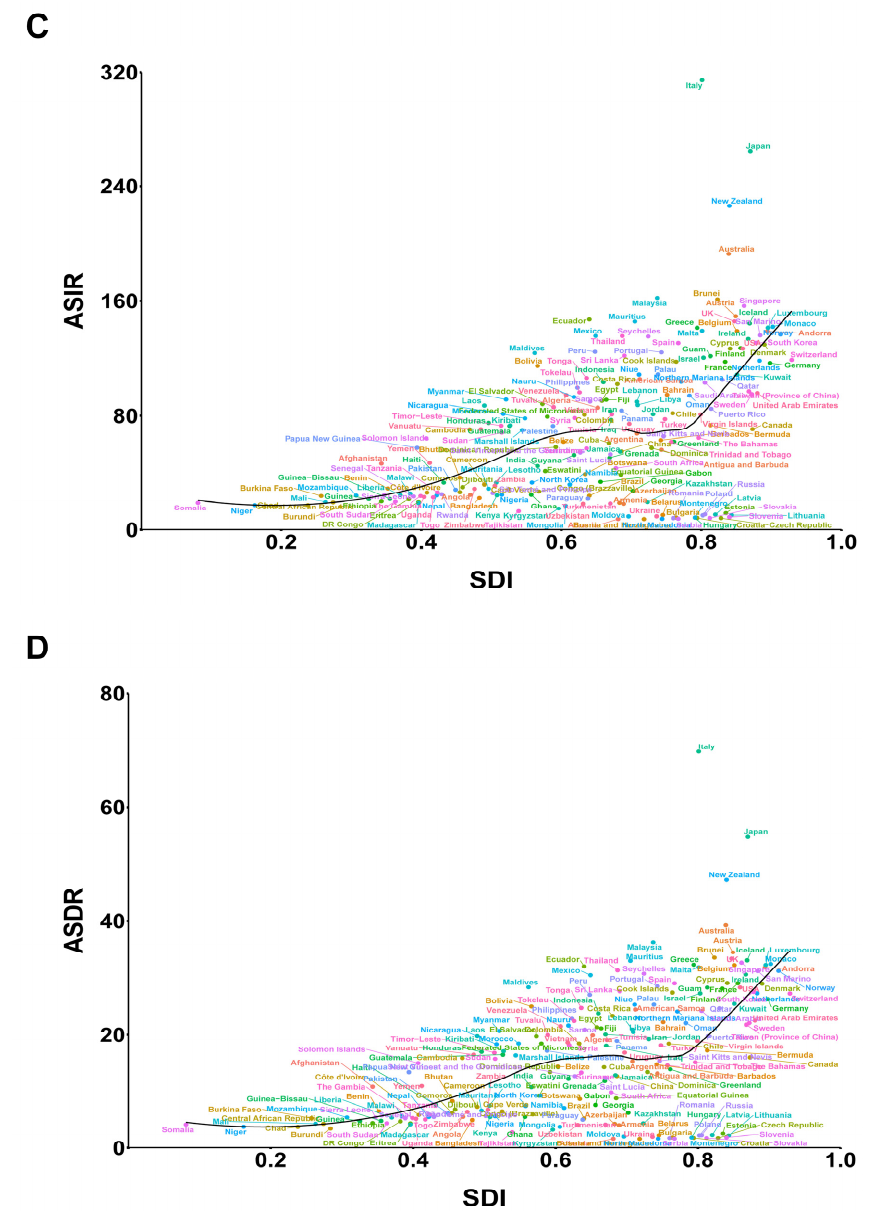
Figure 4. Correlation between SDI and ASR of PCOS at regional and national levels. ( A ) Correlation between SDI and ASIR (per 100,000) at the regional level from 1990 to 2019. ( B ) Correlation between SDI and ASDR (per 100,000) at the regional level from 1990 to 2019. ( C ) Correlation between SDI and ASIR at the national level in 2019. ( D ) Correlation between SDI and ASIR at the national level in 2019. ( A , B ) Colored lines show global and region values for age-standardized incidence rates. Each point in a line represents 1 year starting in 1990 and ending in 2019. The black line represents the average expected relationship between SDI and ASR for PCOS from all regions from 1990 to 2019. ( C , D ) Each colored dot above represents a country. The black line represents the average expected relationship between SDI and ASR. SDI, socio-demographic index; ASR, age-standardized rates; PCOS, polycystic ovary syndrome; ASIR, age-standardized incidence rate; ASDR, age-standardized disability-adjusted life years